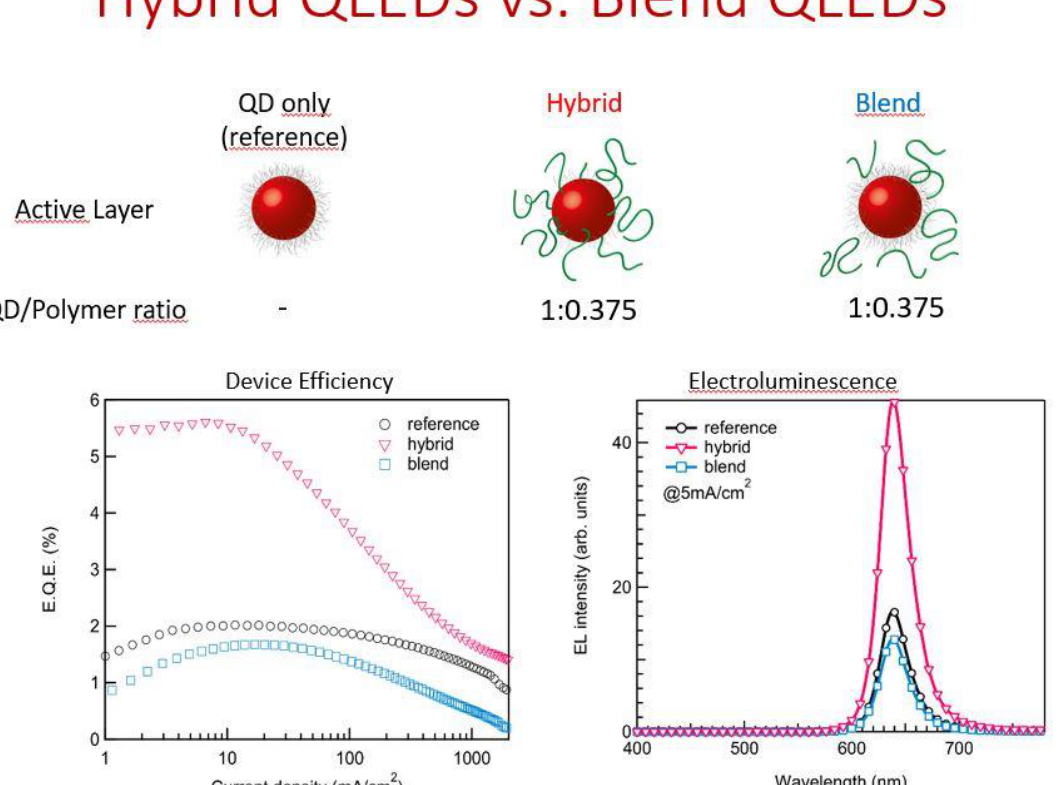
Figure 13. Results of the comparison of CdSe QLEDs with a single layer of fluorescent QDs (left, reference) as well as polymer coated hybrids and blends of unfunctionalized QDs and polymer; see [25] for more details; reproduced with permission of [25], published by Wiley-VCH, 2016 .